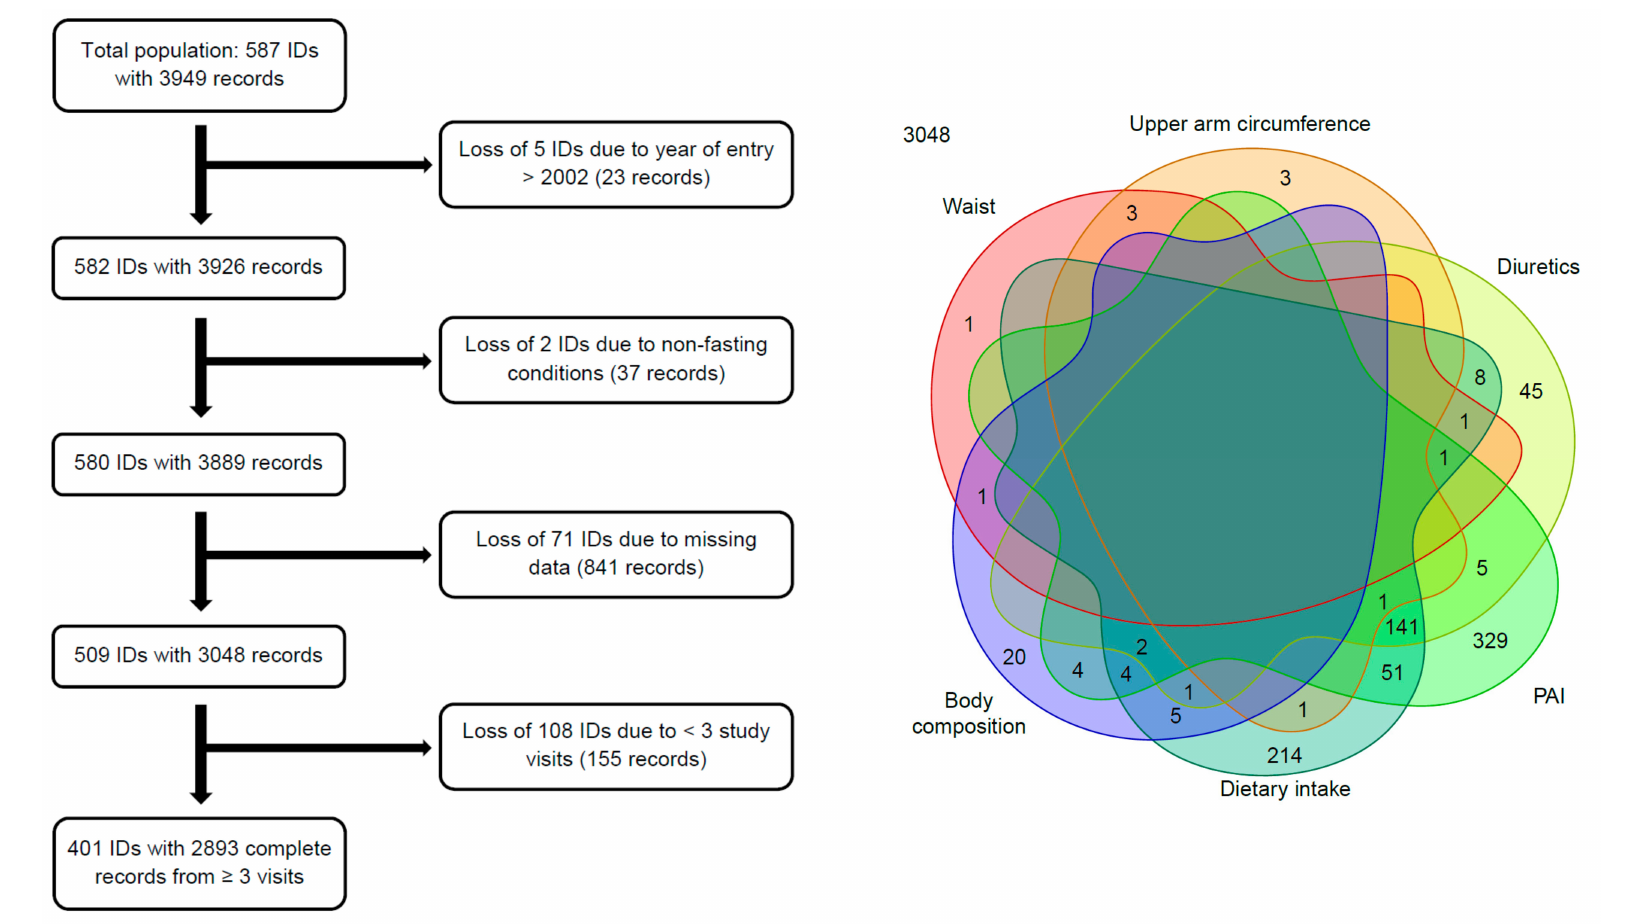
Figure 1. Reasons for losing or excluding subjects from the analyses. Left : This flowchart displays the numbers and reasons for losing or excluding subjects (indicated by ID) and / or records. Right : The Venn diagram states more precisely the sources and numbers of losses of the 841 incomplete data records. Each colored shape represents the set of records, which have a missing value in the variable naming the shape. The inscribed numbers are the counts of those records. A model variable that does not appear here has no missing values at all. PAI, physical activity